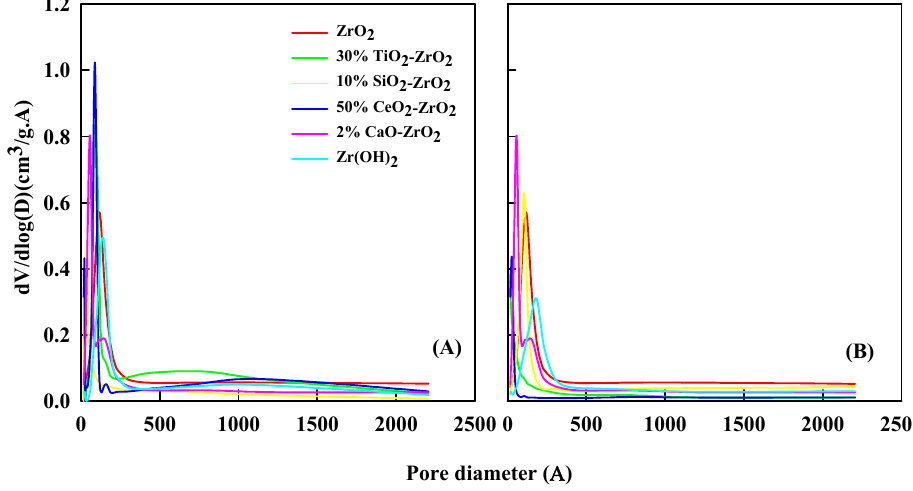
Figure 3. Pore-size distribution of treated catalyst ( A ) before reaction and ( B ) after reaction. Table 3. Catalyst particle size and BET surface area before reaction.